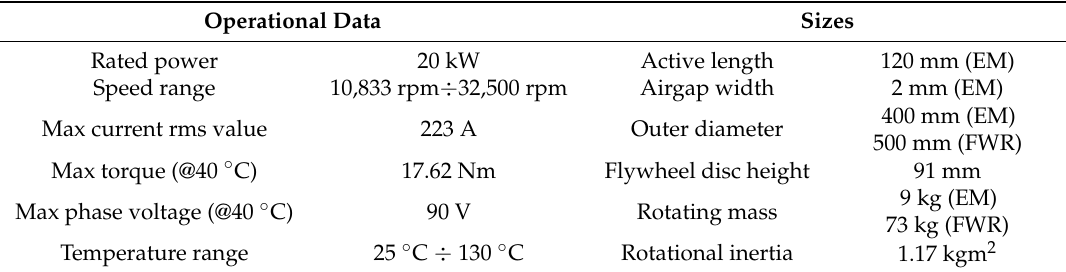
Table 2. Main operational FWR an EM data and